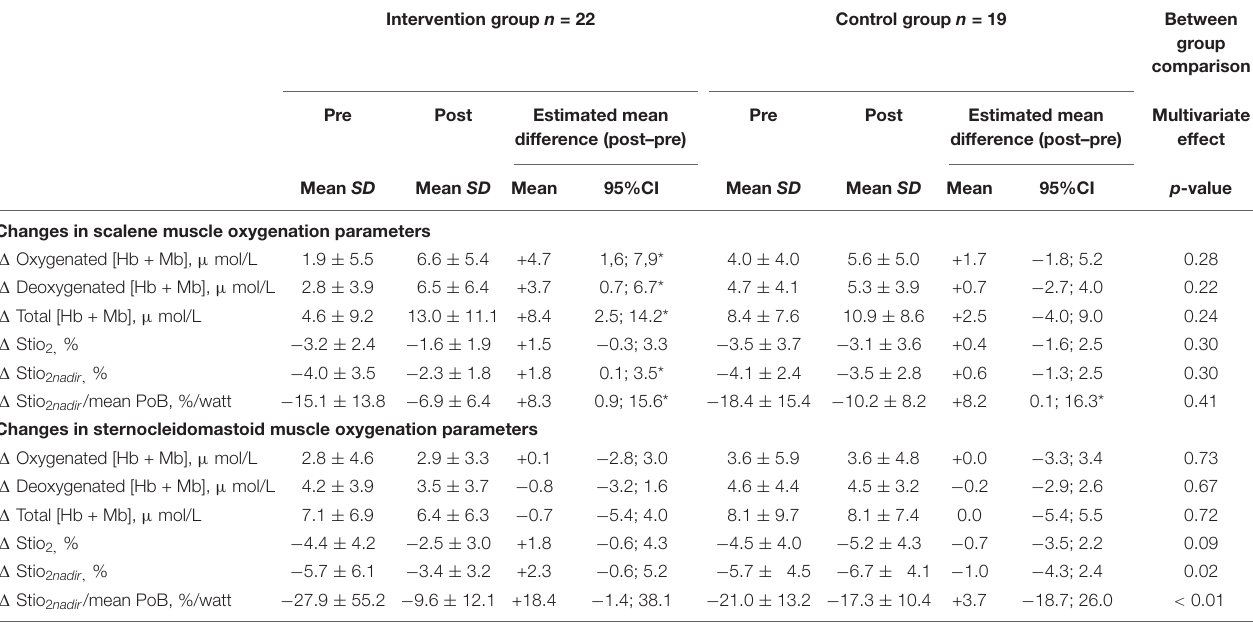
TABLE 5 | Changes in inspiratory muscles oxygenation parameters during the standardized loaded breathing tasks.